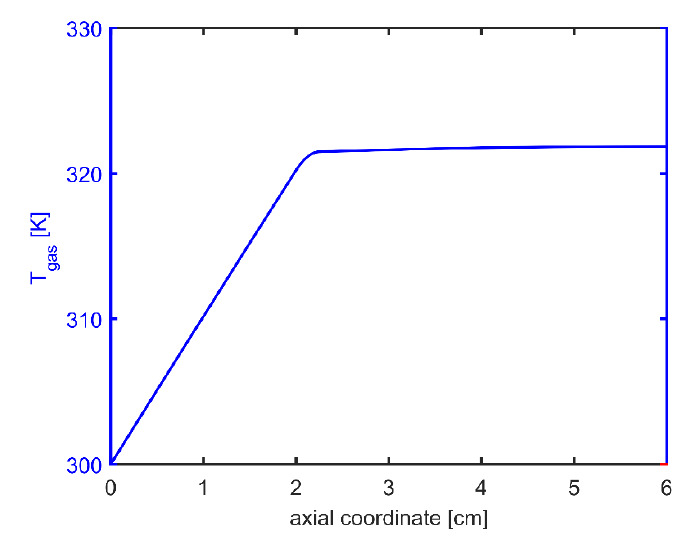
Figure 10. Axial profiles of temperature predicted by PFR computations.